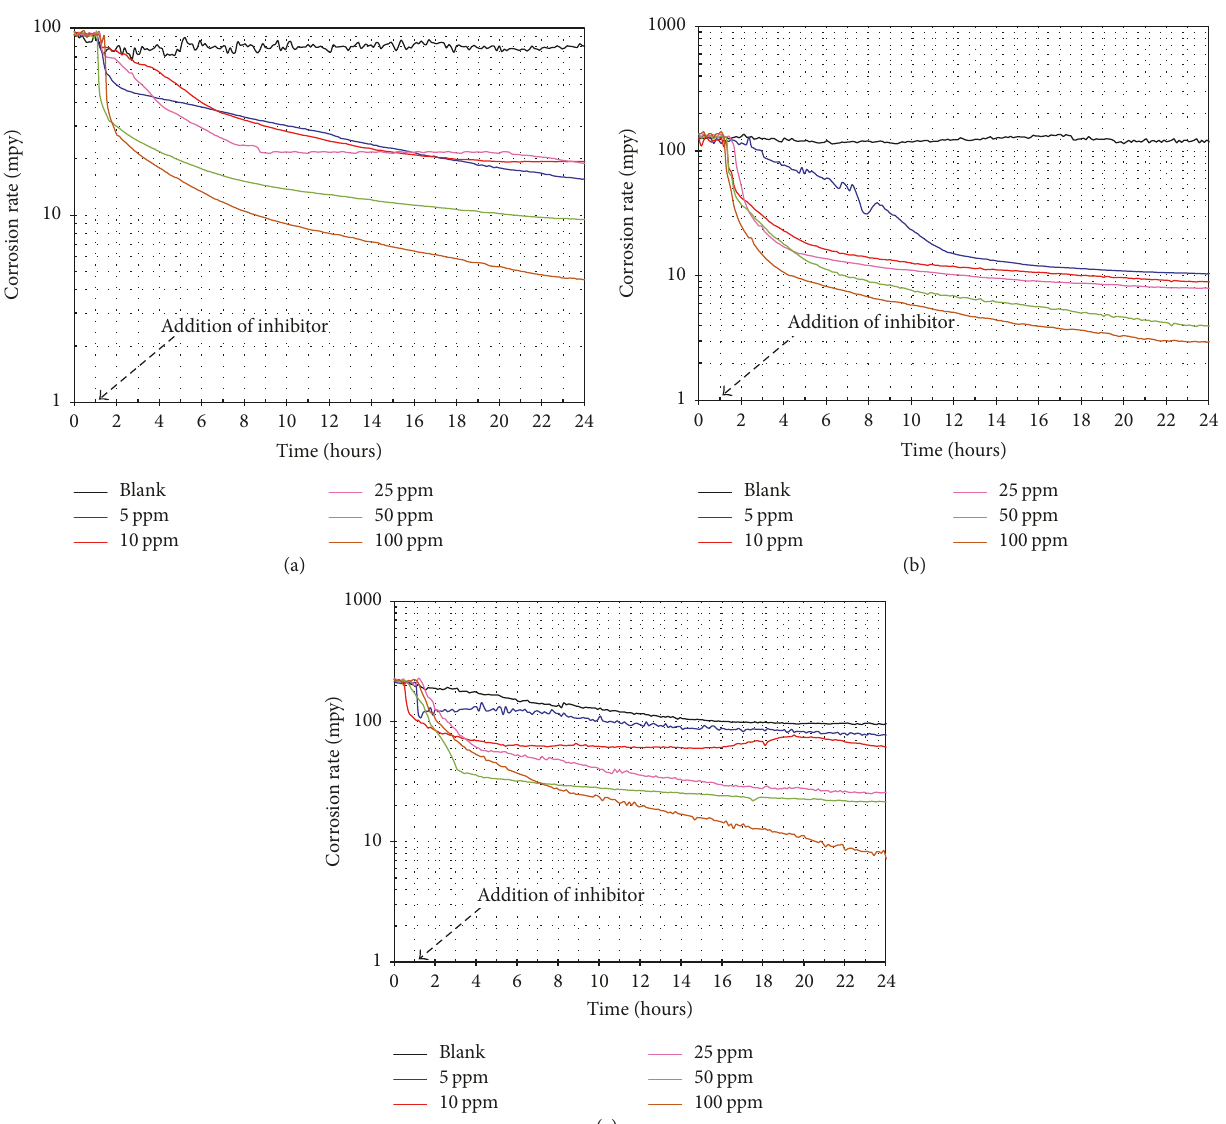
Figure 2: Variation of corrosion rate determined by RPL (real-time monitoring) versus time for API X-70 steel exposed to 3.5% NaCl solution saturated with CO 2 at different concentrations of fatty amide: (a) 30 ∘ C, (b) 50 ∘ C, and (c) 70 ∘